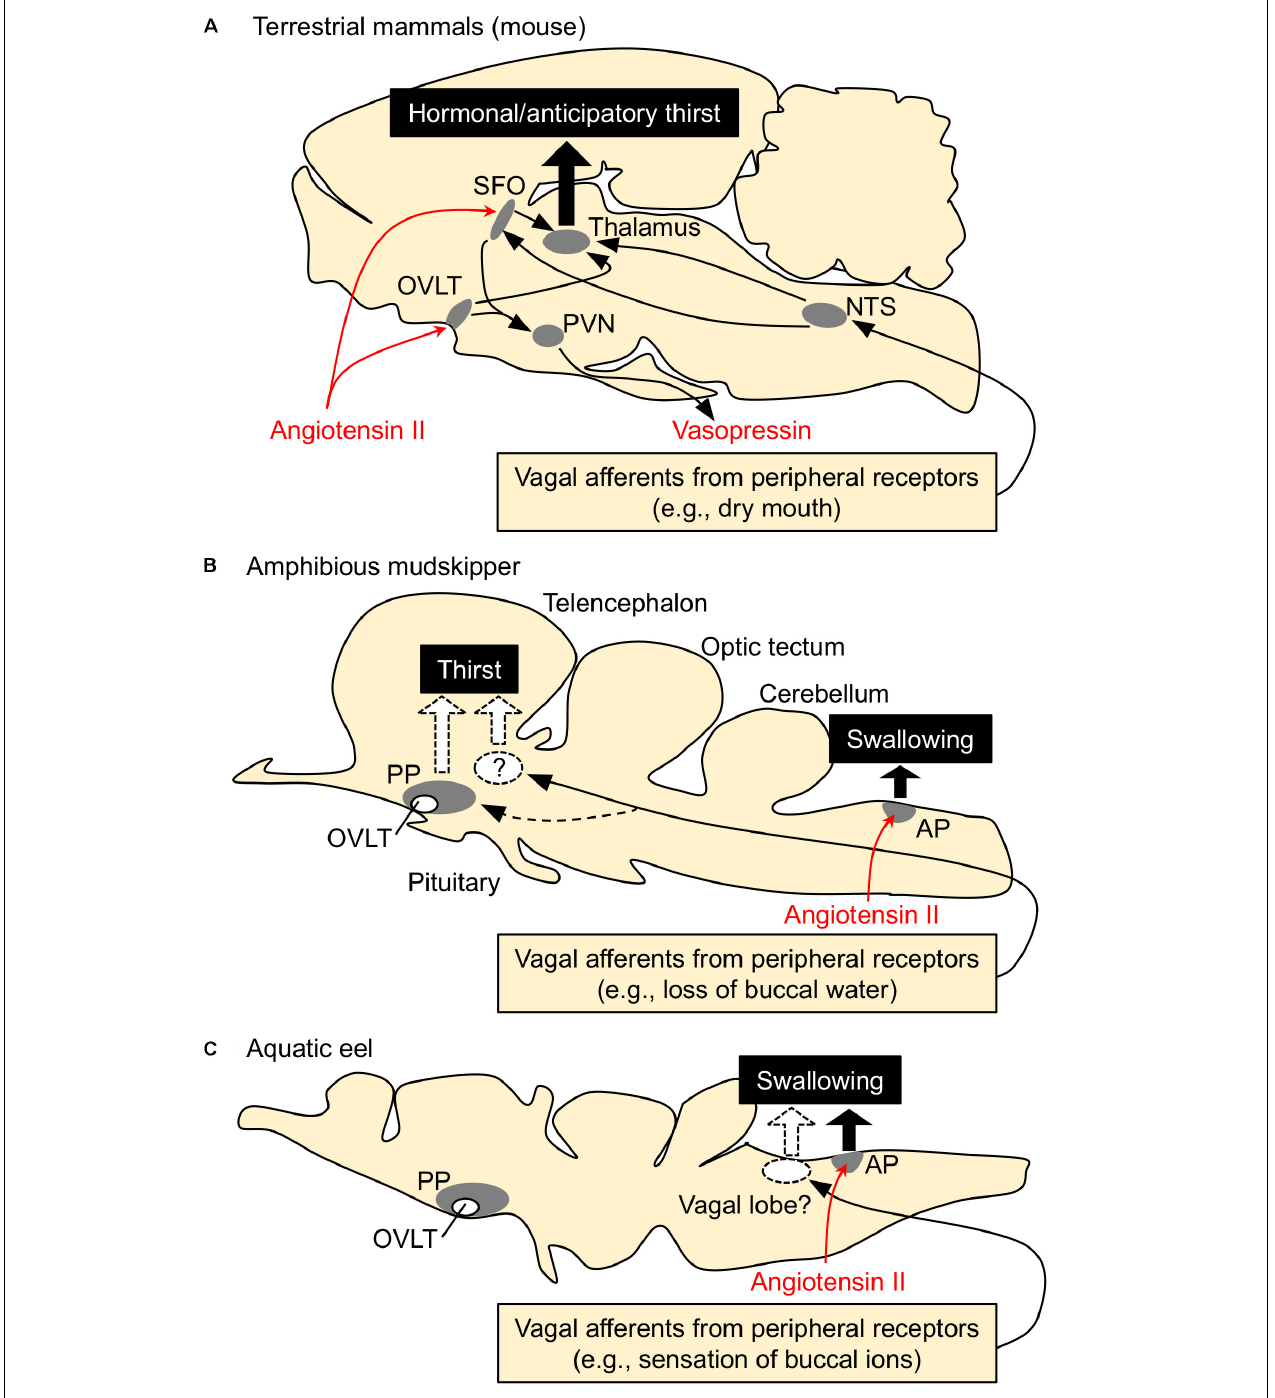
FIGURE 2 | Schematic drawing for the regulatory mechanisms of drinking behavior in terrestrial mammals, amphibious mudskippers, and aquatic eels. Systemic angiotensin II acts on the circumventricular organs (CVOs) that are outside the blood-brain barrier. Among CVOs, the area postrema (AP) and the organum vasculosum of the lamina terminalis (OVLT) exist in mice, mudskippers, and eels, but the subfornical organ (SFO) is identified only in tetrapods. (A) Thirst-inducing mechanisms in mice. Systemic angiotensin II is perceived by the neurons in the SFO and OVLT. The signal is transmitted to the thalamus for thirst inducement, and to the paraventricular (PVN) and supraoptic (SON) nuclei for vasopressin secretion. The generation of thirst seems to involve activation of the cortex, which might be mediated by relay neurons in the medial parts of the thalamus. Signals from peripheral receptors (e.g., dry mouth, buccal food) also reach thirst-regulating